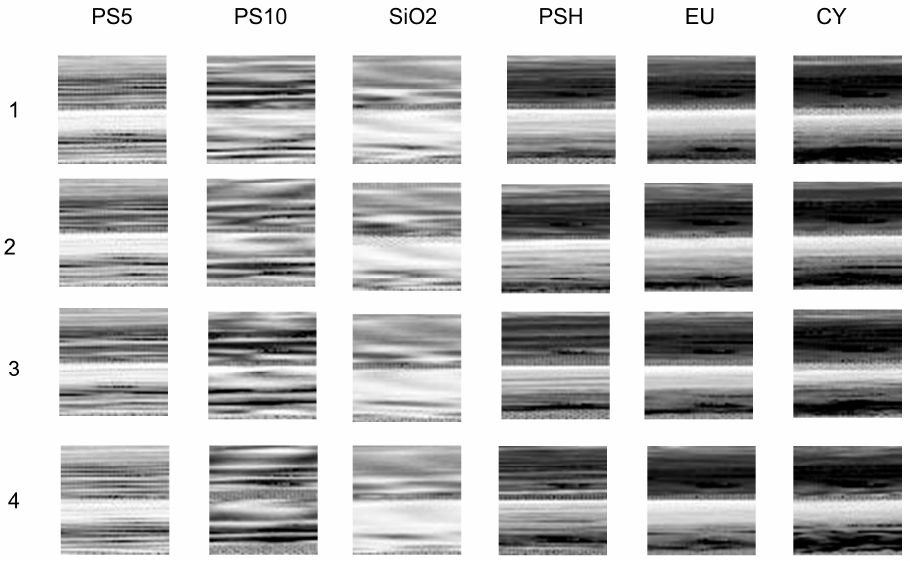
Figure 5. Grayscale maps realigned from PCLAR for six categories of particles.